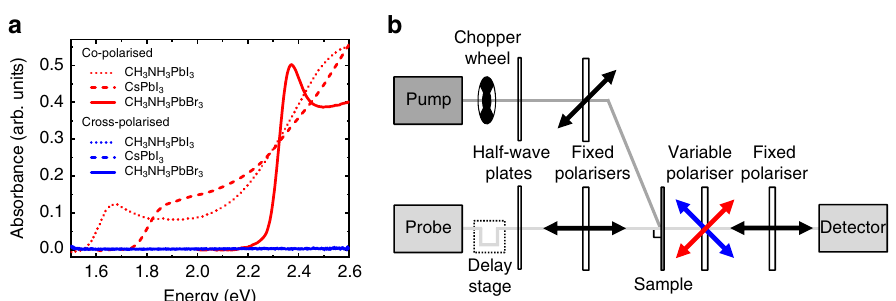
Fig. 1 Sample properties and experimental setup. a Steady state linear absorption spectra of the investigated hybrid perovskite thin fi lms. In co-polarized measurements (red), polarisers placed before and after the sample are aligned parallel. In cross-polarized measurements (blue), polarisers placed before and after the sample are aligned perpendicular. No intrinsic dichroism is observed. b Sketch of the experimental setup used for polarization selective transient absorption spectroscopy. The linear polarization of the pump pulse is set at an angle of 45° with respect to the linear polarization of the probe pulses before the sample. A second set of polarizers after the sample detects the linear polarization component of the probe pulses either parallel or perpendicular to the pump pulse polarization